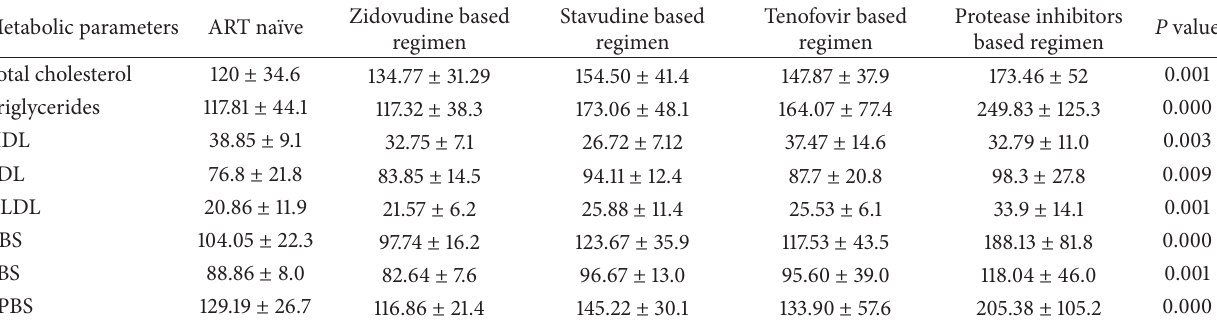
Table 5: Metabolic parameters in study